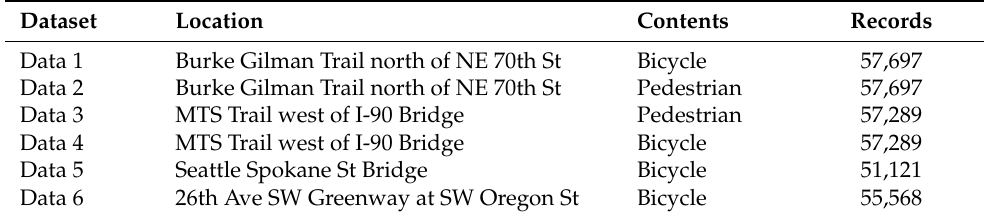
Table 1. Traffic datasets used to evaluate the considered models.